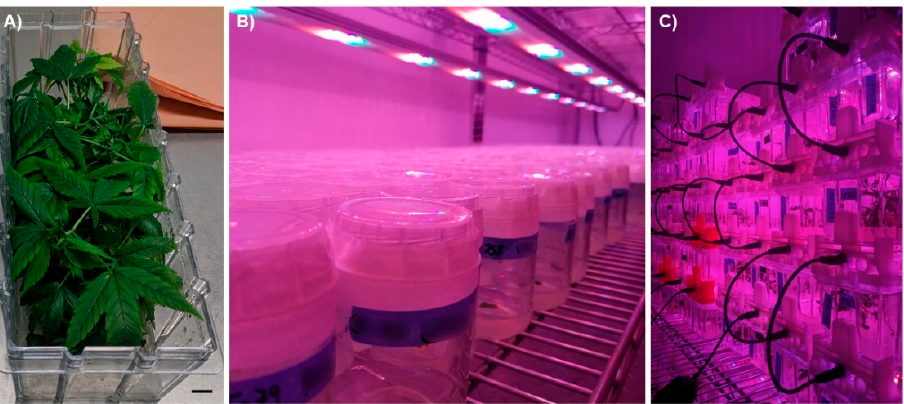
Figure 3. Healthy C. sativa explants growing in We-V boxes ( A ). Callus cultures growing in glass culture vessels under LED lighting in a controlled environment growth chamber ( B ) and high- density stackable culture vessels (We-V) with individually programmable LED lighting ( C ) demonstrate the variety and density with which C. sativa can be cultured under In Vitro